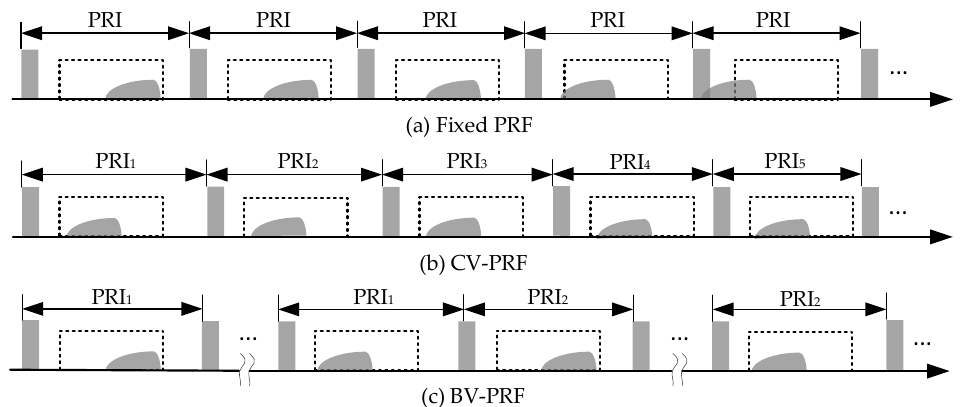
Figure 3. Diagrams of pulse transmission sequences. ( a ) Fixed PRF. ( b ) CV-PRF. ( c ) BV-PRF.